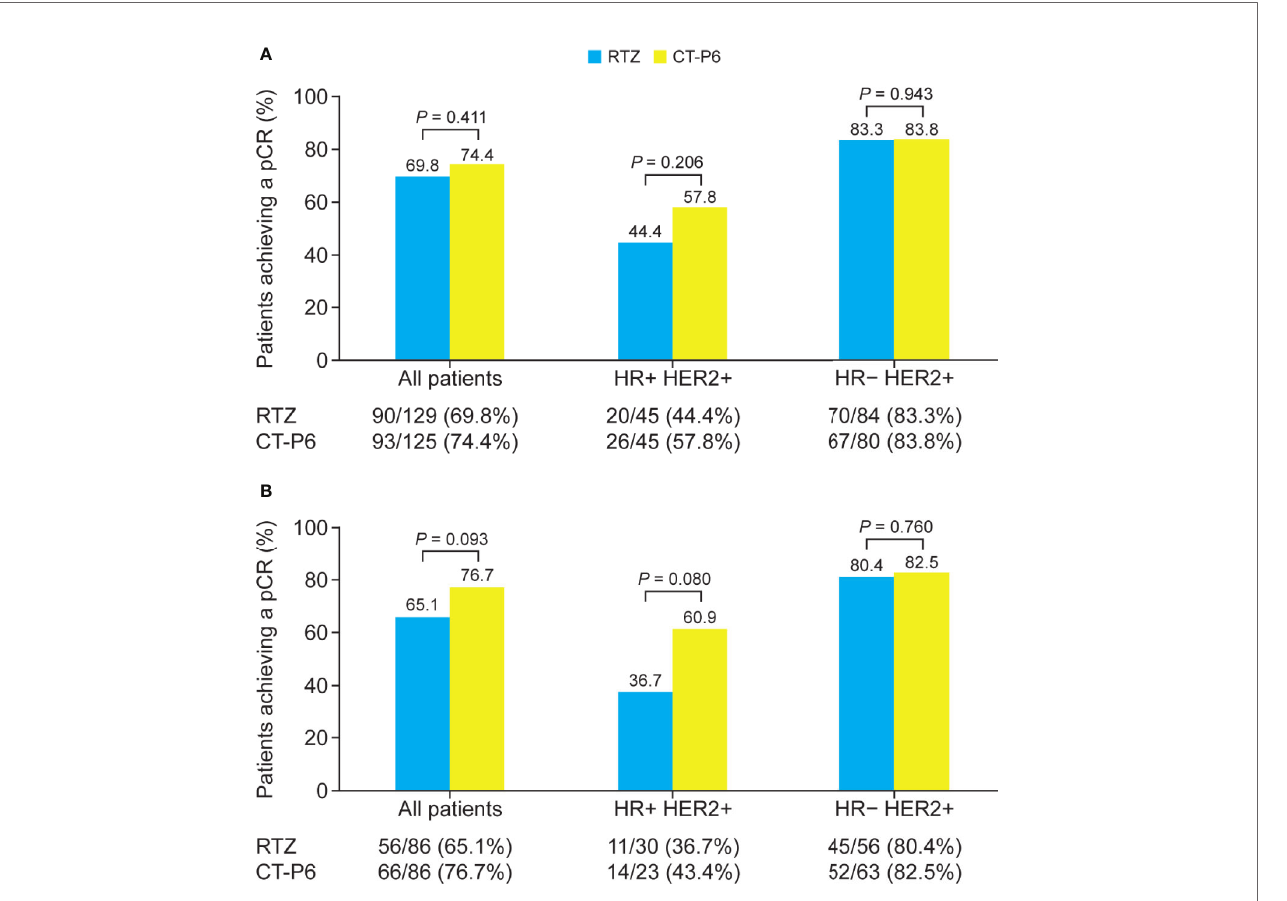
FIGURE 2 | Percentage of patients with HER2-positive early-stage breast cancer who achieved a pCR following CT-P6 or RTZ treatment, strati fi ed by HR status for (A) all patients and (B) propensity score matching cohort. HER2, human epidermal growth factor receptor 2; HR, hormone receptor; pCR, pathologic complete response; RTZ, reference